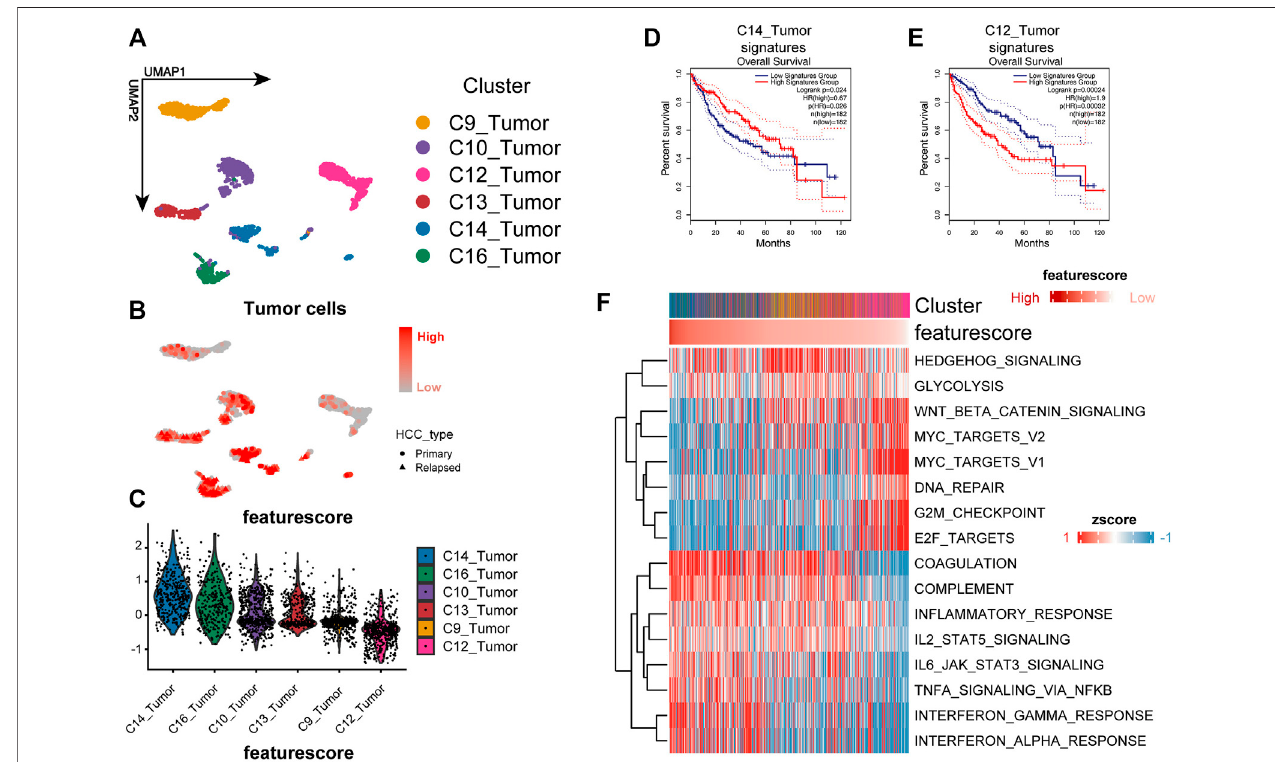
FIGURE 2 | Three-gene signature could identify more malignant cells well in the single-cell level. (A) UMAP plot shows the cluster of tumor cells. The annotation of cell types follows the original authors. (B,C) Feature plot and violin plot show the feature score of each cluster. The higher the feature score, the less malignant is the tumor. (D,E) Kaplan – MeierplotoftheC14_TumorsignatureandC12_TumorsignatureinTCGAcohort. (F) HeatmapshowstheGSVAenrichmentofeachcell;cellsare sorted according to the feature score.